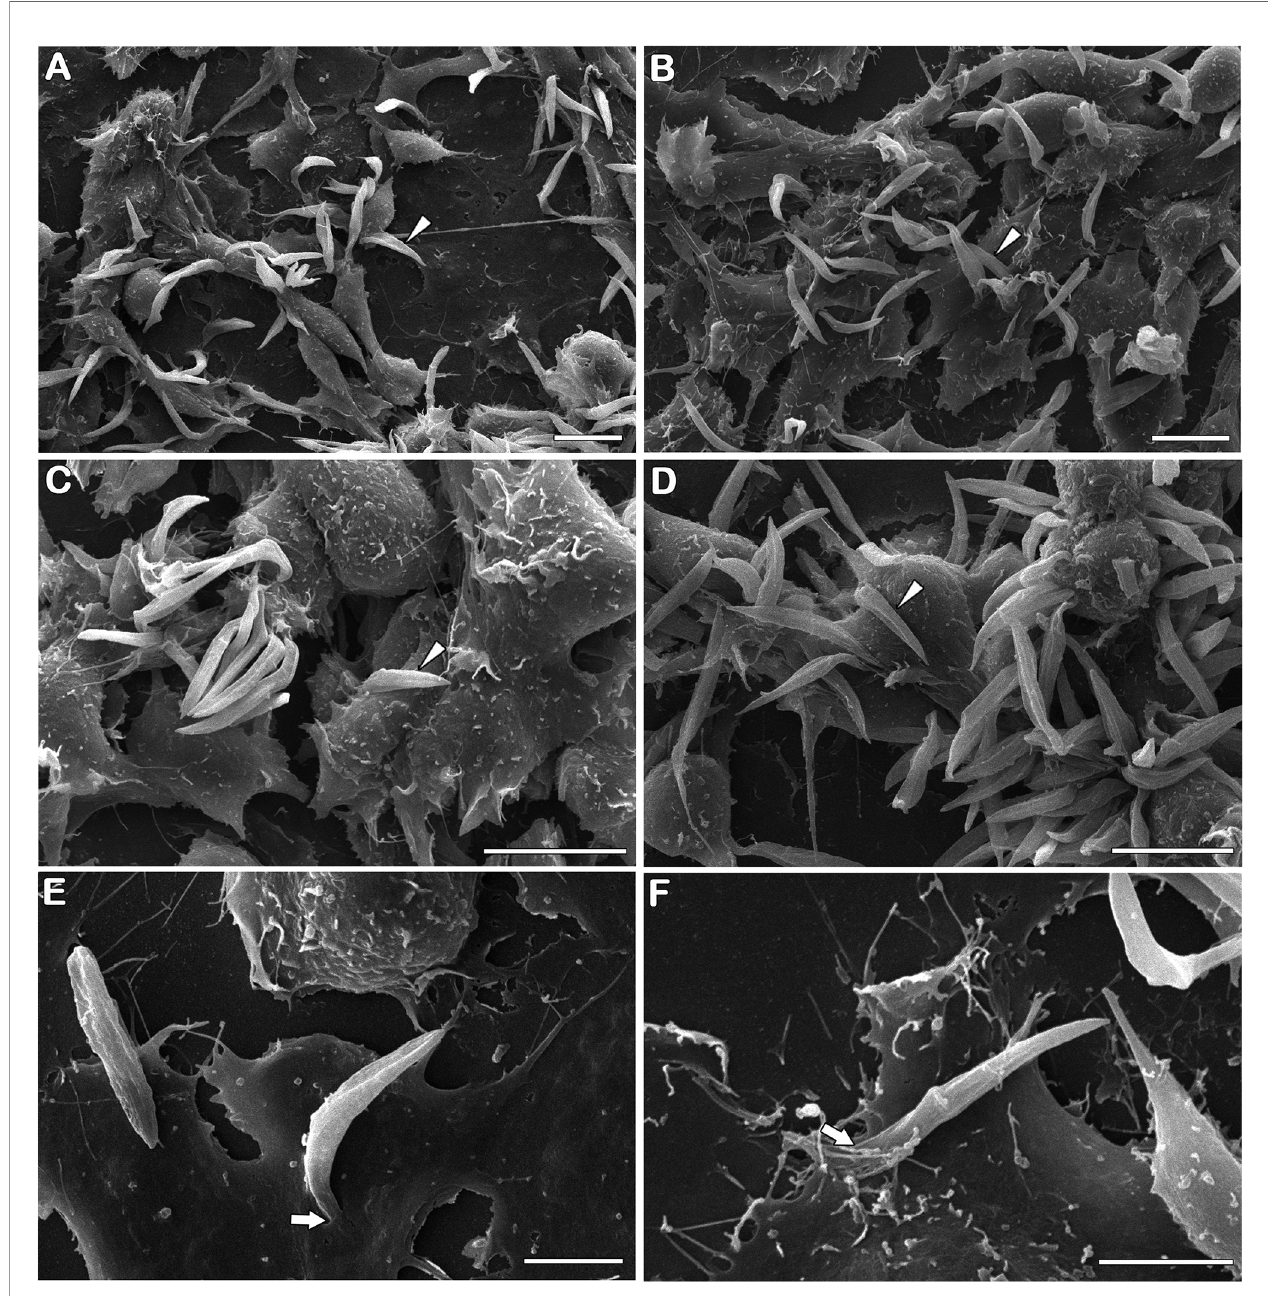
FIGURE 4 | Strigomonas culicis infects Aag2 cell culture by fl agellum insertion in epithelial cells. Scanning electron microscopy analysis of (A, C, E) wild type (WT) and (B, D, F) hydrogen peroxide (H 2 O 2 )-resistant (WTR) interaction with Aag2 at 24 h. Arrowheads point to adhered parasites, being possible to observe an increase in WTR-infected groups. Despite that, parasite – host interaction occurs similarly independent of the strain used mainly by fl agellum insertion (arrows). Scale bars represent 10 µm (A – D) and 5 µm (E, F) . Representative micrographs of three independent